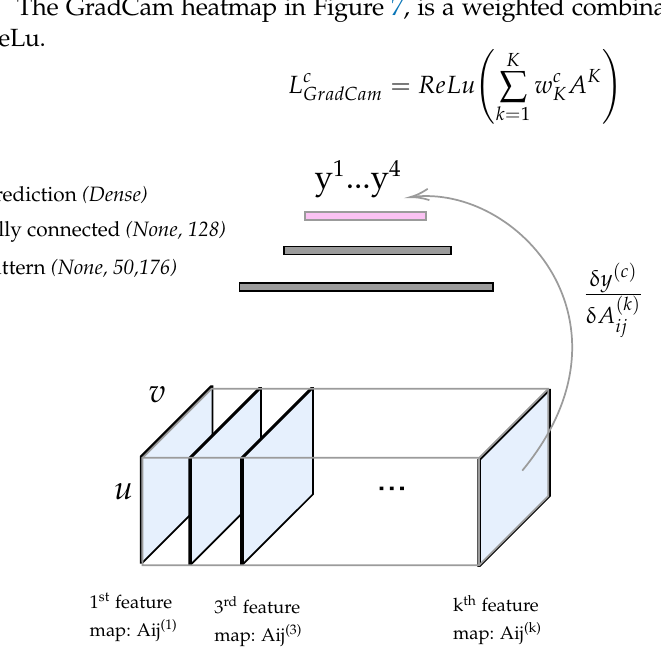
Figure 7. GradCam visualization. The last Conv layer can be thought of as the features of a classifica- tion model: y c = f ( A 1 , . . . , A 512 )